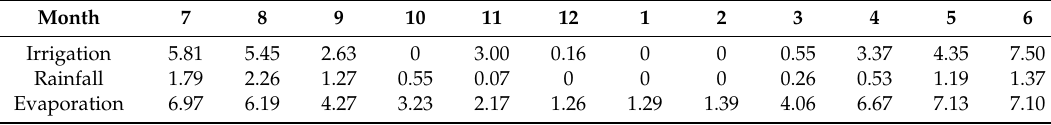
Figure 5. Study area: ( a ) Contour of the top elevation; ( b ) contour of the bottom elevation of the loess layer; ( c ) contour of the initial groundwater level; ( d ) distribution of the observation holes for the groundwater level. Table 1. Boundary conditions of the upper surface of the model ( × 10 − 4 m/day).